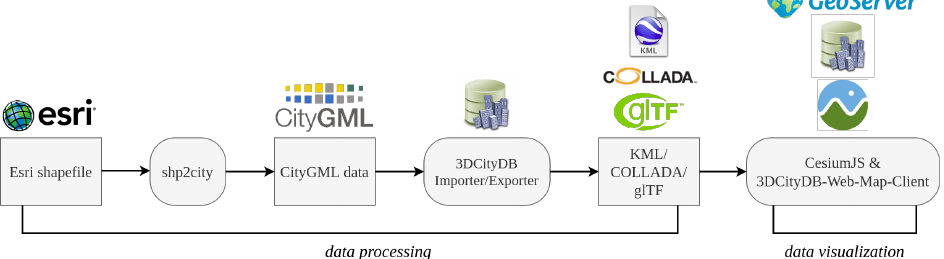
Figure 4. Workflow for the visualization of CityGML data on a virtual globe created using CesiumJS.